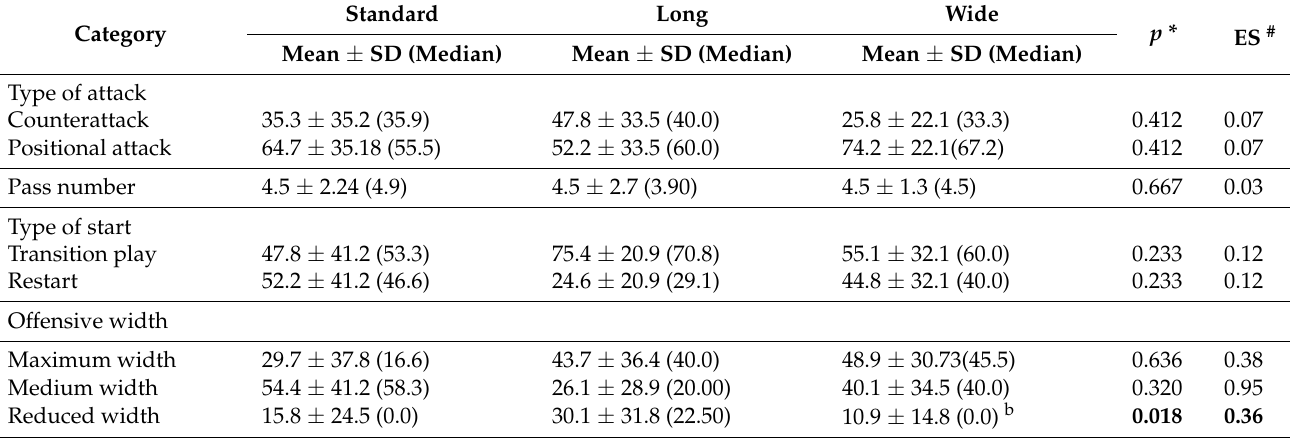
Table 5. Comparison of playing tactics between the three different pitch configurations in the team possessions that led to GS.